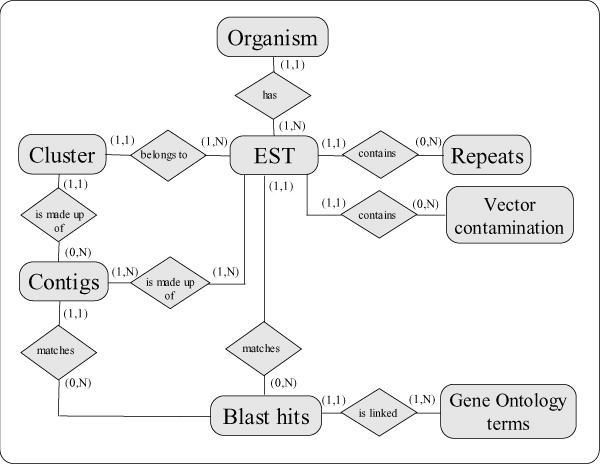
The Entity-Relationship (ER) diagram of the MySQL database. The ER diagram is reported to show the database structure schema. The schema describes the entities included in the database and their relationships.